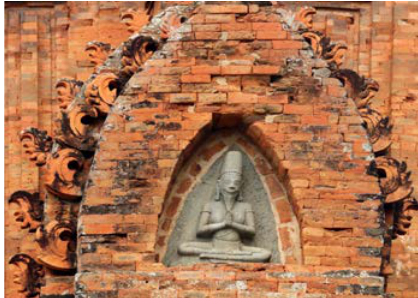
4. POINT CLOUDS BY LASER SCANNING AND SfM